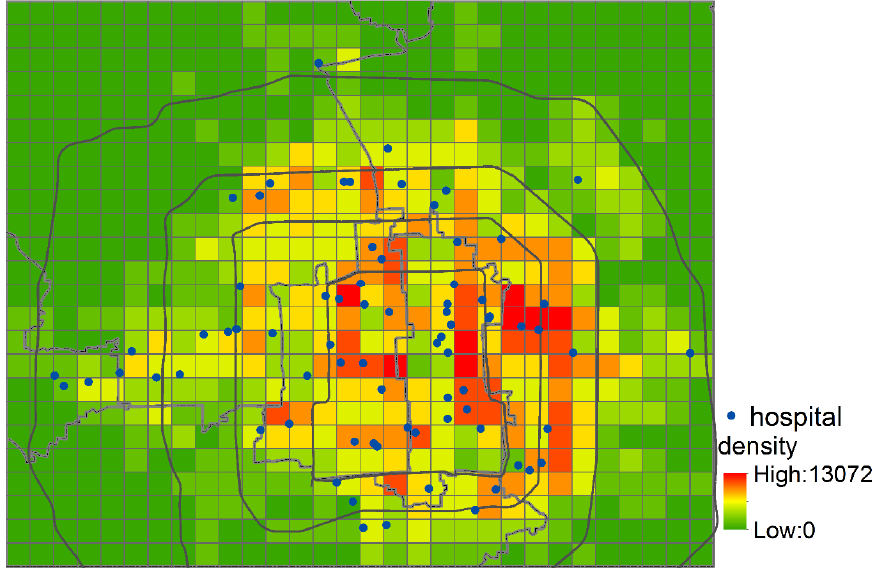
Figure 4. The overall hospital service areas.